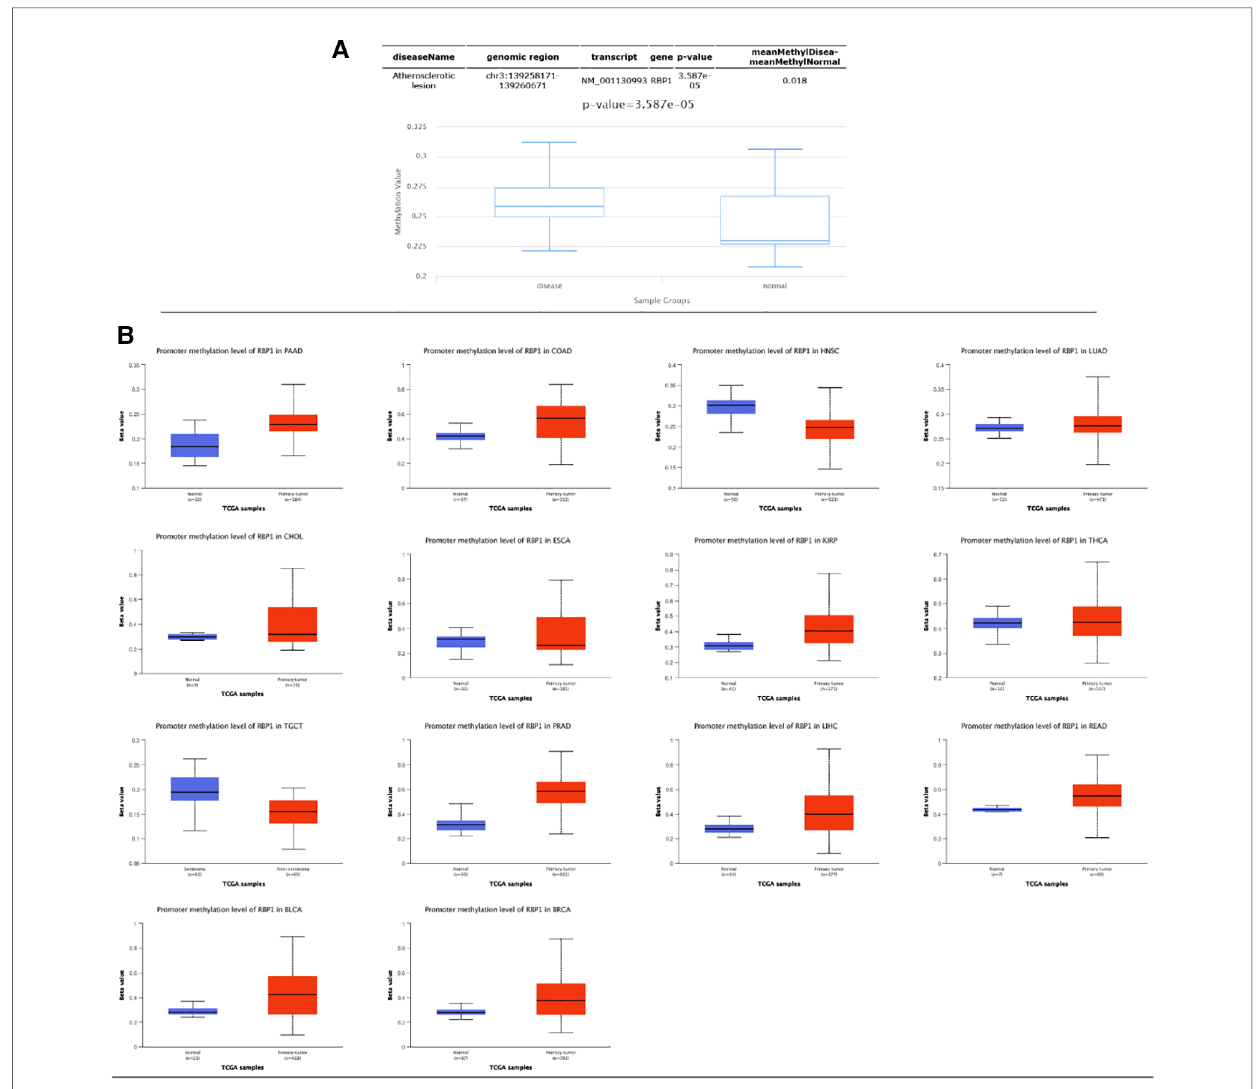
FIGURE 5 Methylation and clinical staging analysis. (A) Signi fi cant hypermethylation of RBP1 in atherosclerosis. ( B ) Methylation analysis of RBP1 in individual tumors, of which it was signi fi cant in 14